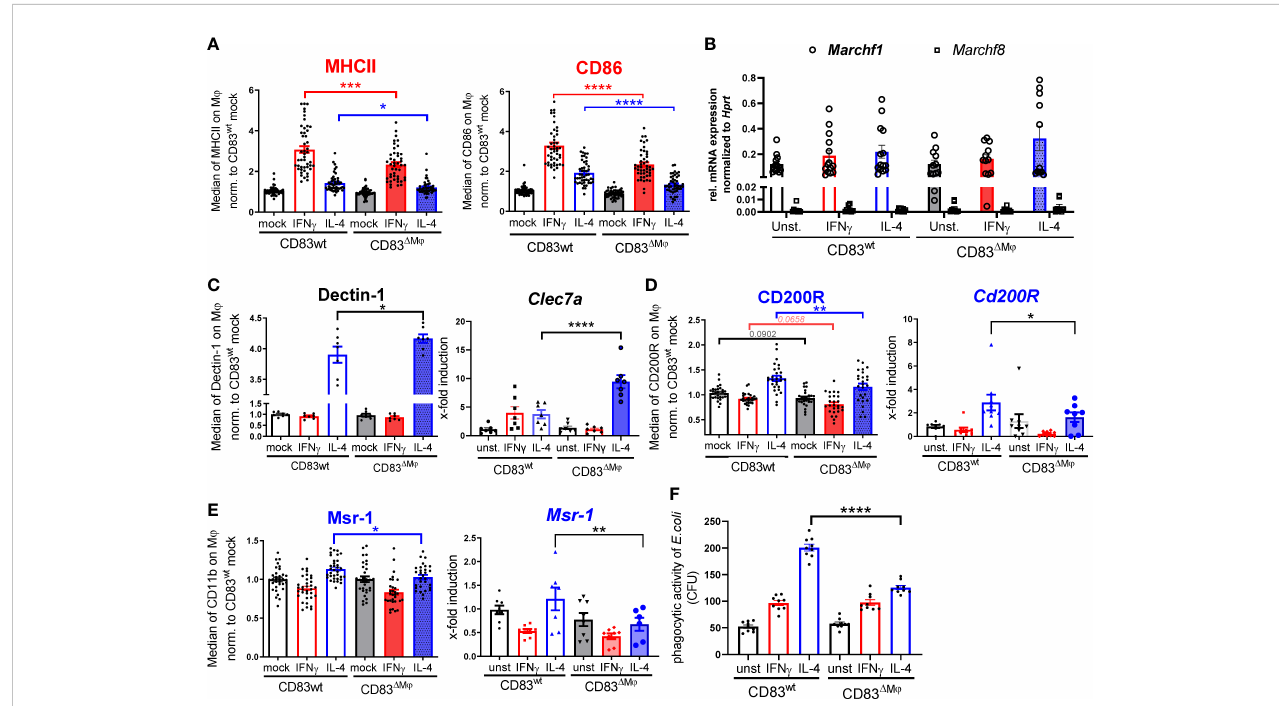
FIGURE 3 CD83 de fi ciency modulates the pro-resolving phenotype of IL-4 stimulated M j . BMDM were generated and differentiated into in fl ammatory CAM or AAM, using IFN- g or IL-4 respectively, for 16h. (A) Assessment of surface MHC-II (n ≥ 47) and CD86 (n ≥ 47) expression levels by fl ow cytometry on stimulated murine wt and CD83-de fi cient M j . (B) qPCR analyses of Marchf1 and Marchf8 in M j derived from CD83wt or CD83 cKO mice (n = 5). (C) Analyses of Dectin-1 surface expression levels (left bar graph) and mRNA expression levels (right bar graph, via fl ow cytometry and qPCR, respectively). Signi fi cantly increased Dectin-1 expression levels on IL-4 stimulated CD83-de fi cient M j (n = 7). (D) Analyses of CD200R surface expression (left bar graph, n ≥ 29-31) and mRNA expression (right bar graph, n ≥ 8) revealed signi fi cantly decreased levels on IL-4 stimulated CD83-de fi cient M j (E) Analyses of MSR-1 surface expression (left bar graph, n ≥ 31) and Msr-1 mRNA expression (right bar graph, n = 6) revealed signi fi cantly decreased levels on IL-4 stimulated CD83-de fi cient M j . (F) Assessment of phagocytic activity via gentamicin protection assays revealed signi fi cantly decreased capacity to engulf E.coli . Statistical analyses were performed by One-way ANOVA or the appropriate corresponding non-parametric test. Data are represented as mean ± SEM. Experiments were performed at least three times. *p< 0.05; **p<0.01; ***p<0.001; **** p< 0.0001. The absence of asterisks indicates that there is no statistical signi fi